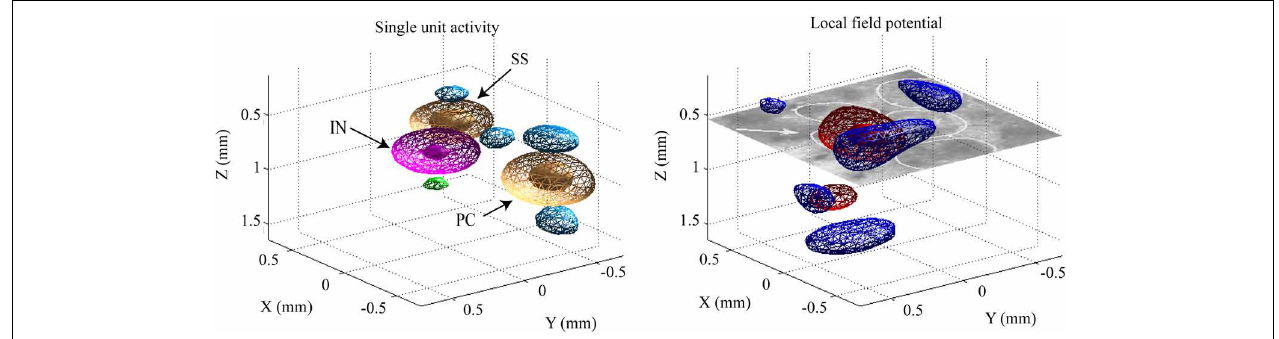
FIGURE 5 | Example of the CSD distributions estimated for single unit (left panel) and population synaptic (right panel) activities. The CSD distributions are represented in three dimensional contours. The contours denoted by meshes and patches represent the weak (30% of the maximum) and strong (70% of the maximum) intensity of the CSD, respectively. In the left panel , orange and magenta are used for the current sink of the excitatory [pyramidal (PC) and spiny stellate (SS) cells] and inhibitory (IN) neurons,